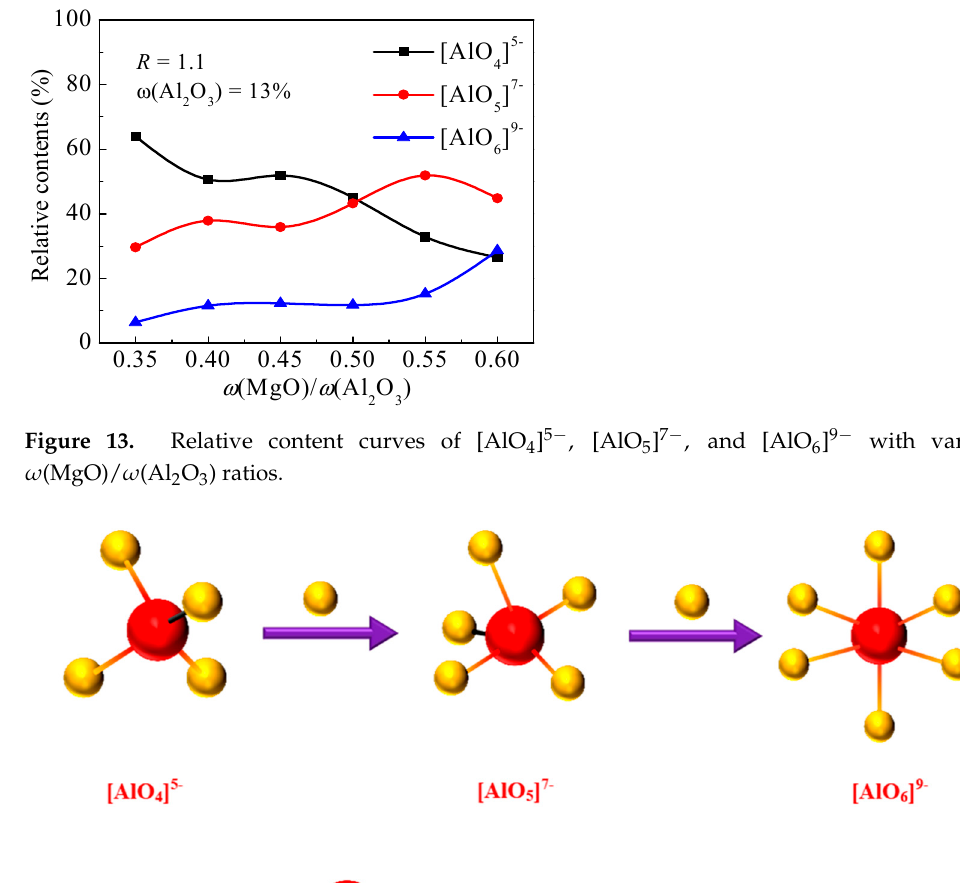
Figure 12. Deconvolution results of the 27 Al-SS-MAS-NMR curves with various ω (MgO)/ ω (Al 2 O 3 ) ratios, and ( a ) the ω (MgO)/ ω (Al 2 O 3 ) is 0.35, ( b ) the ω (MgO)/ ω (Al 2 O 3 ) is 0.40, ( c ) the ω (MgO)/ ω (Al 2 O 3 ) is 0.45, ( d ) the ω (MgO)/ ω (Al 2 O 3 ) is 0.50, ( e ) the ω (MgO)/ ω (Al 2 O 3 ) is 0.55, ( f ) the ω (MgO)/ ω (Al 2 O 3 ) is 0.60.